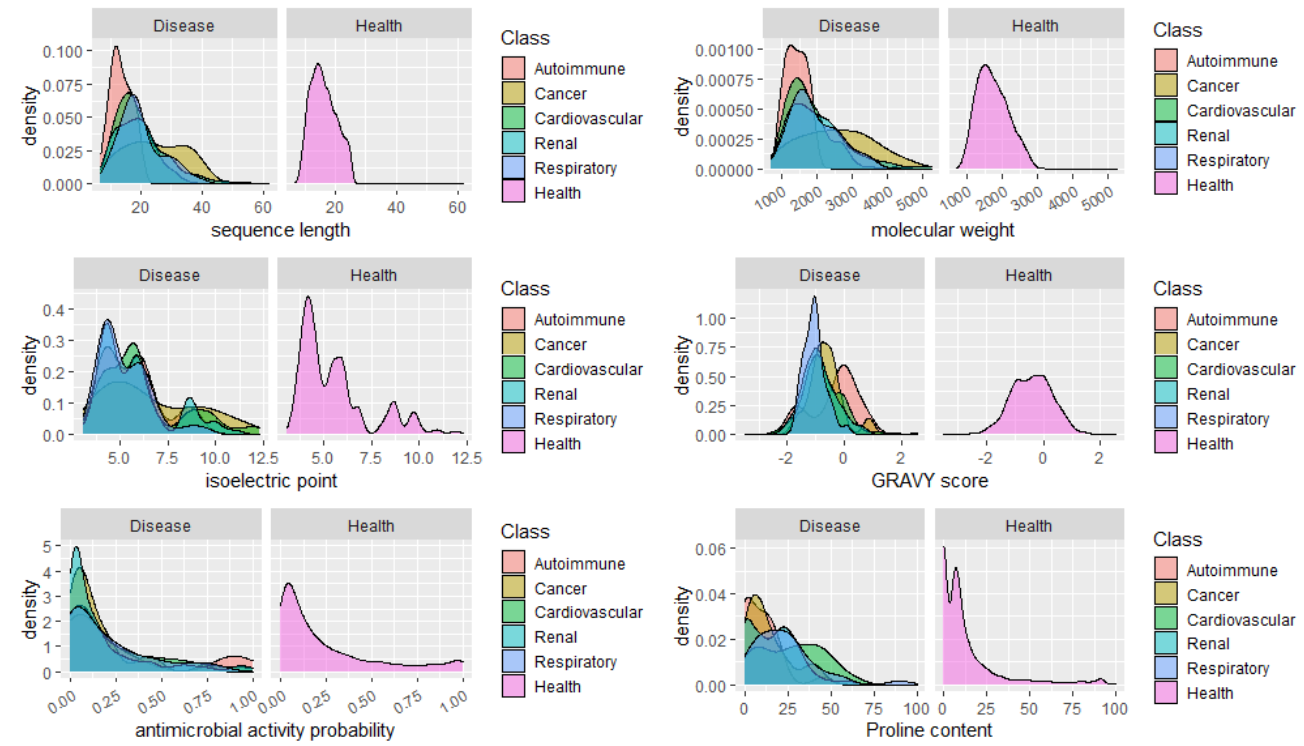
Figure 4. Density plots showing the distribution of peptides in health versus six main disease classes, regarding sequence length, molecular weight, isoelectric point, GRAVY score, antimicrobial peptide probability, and proline content.